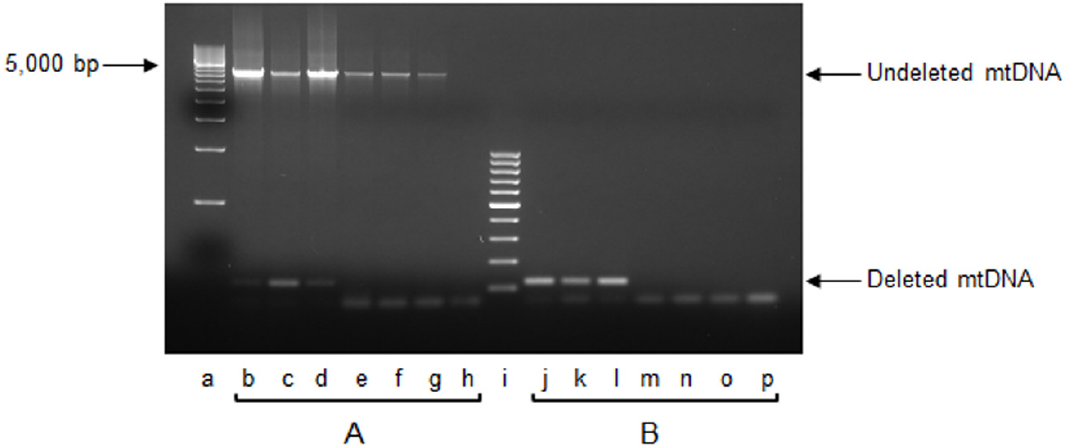
Figure 2. End-point PCR analysis of mouse mtDNA “common deletion”. Representative gel of end-point PCR amplification of total DNA isolated from liver of three 18-month-old wt mice, and three 4-month-old mice, belonging to wt, NTH1 − / − , and OGG1 − / − strains, respectively. ( A ) extension